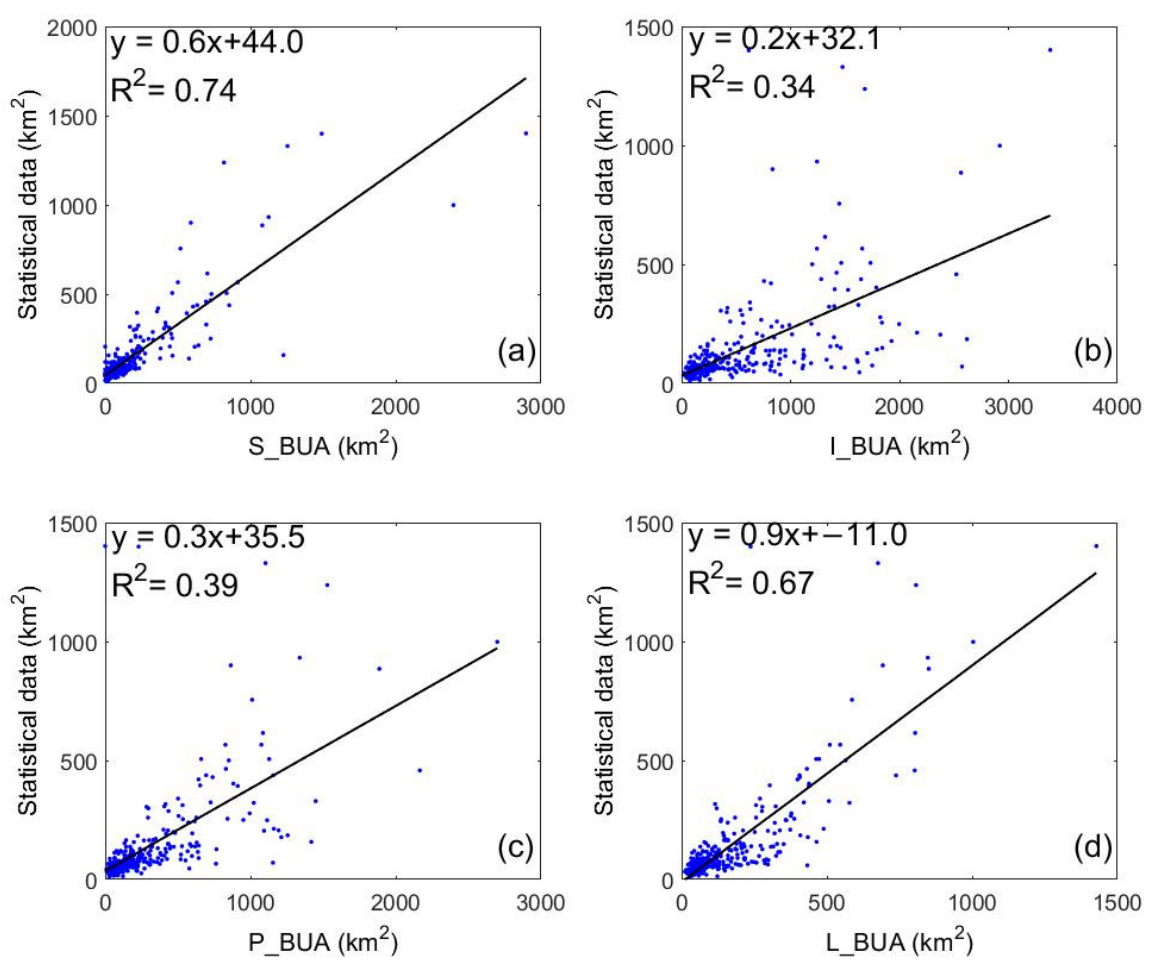
Figure 2. The scatter plot in mainland cities in 2015.